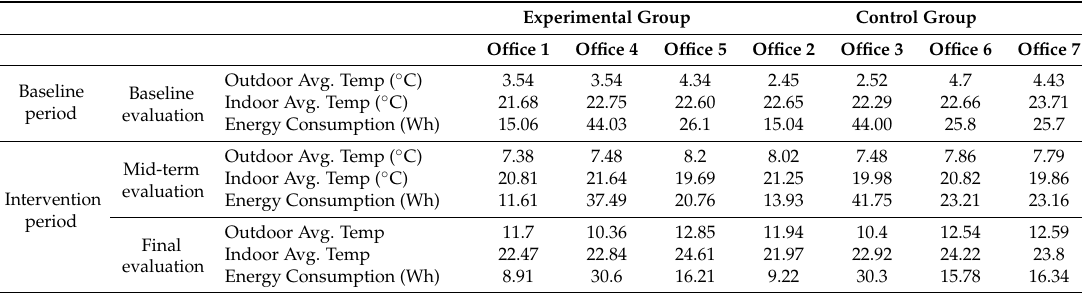
Table 3. Average temperatures and energy consumption by period.